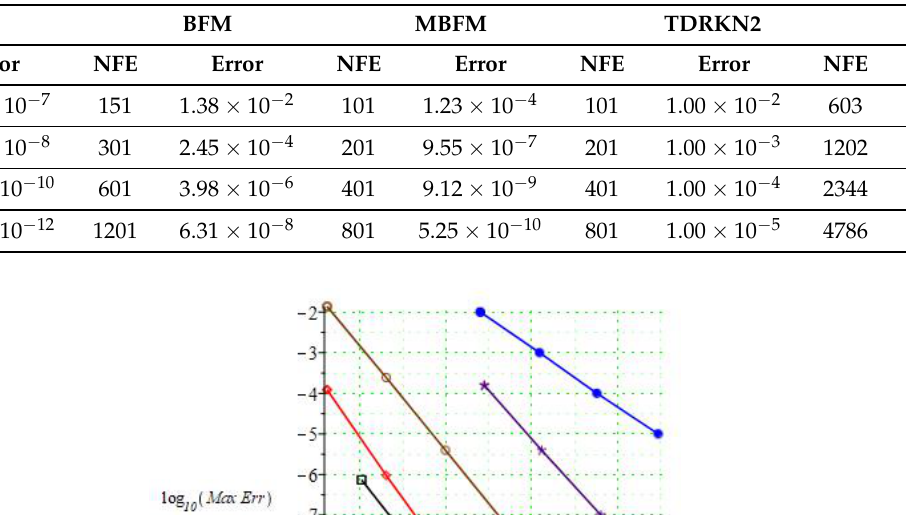
Table 3. Data for Example 3 with ω = 1, δ = 10 − 3 .